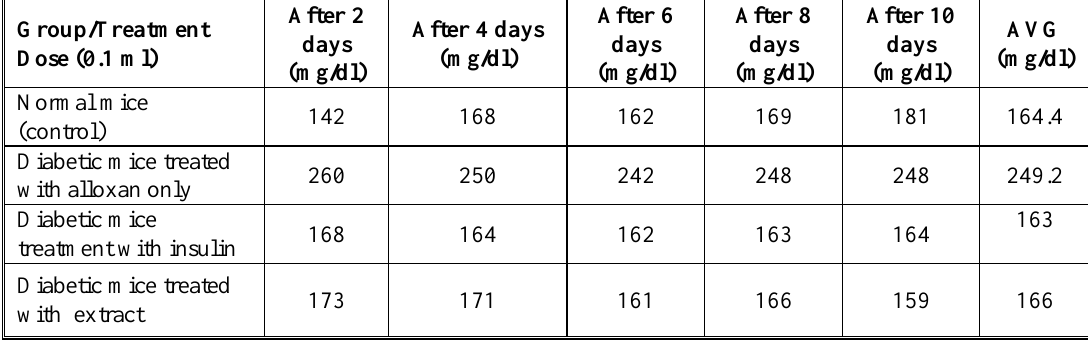
Table 2: Anti-hyperglycemic effects of Arabidopsis thaliana seed extract (200 mg/kg of body weight) on induced diabetic mice Group/Treatment Dose (0.1